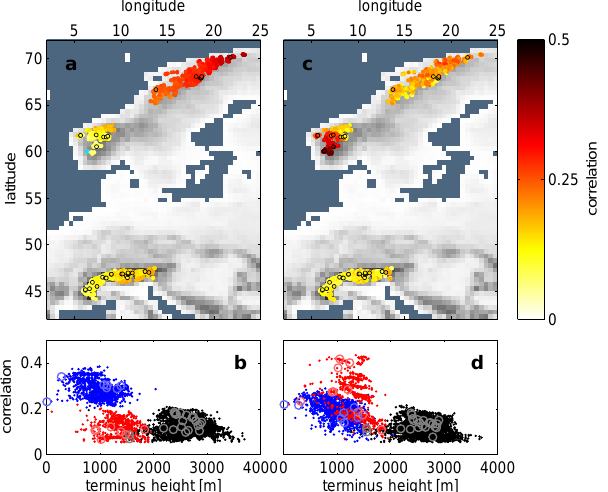
Fig. 10. Mean of the monthly correlations between modelled mass balance anomalies, i.e., MB anom and NAO index during December, January and February (a, b) , and during March to November (c, d) . Markers with black circle (a, c) and circle markers (b, d) indicate the results of the glaciers with more than 12 existing measurements of annual mass balance. Values below the 95% confidence interval have been omitted from the calculation of the mean. Gray back- ground shading: Topography of the CRU TS 3.0 data. In panels (b) and (d) black is for glaciers in the Alps, red for glaciers in southern Scandinavia, blue for glaciers in northern Scandinavia. Note that the correlation values close to zero are the result of calculating the mean of significant, non-zero correlations.